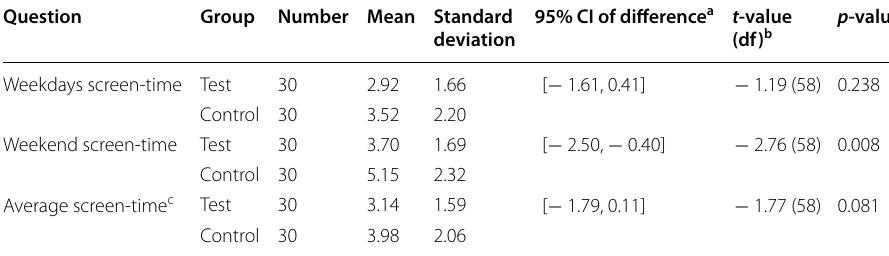
a Difference was calculated as Test–Control. CI, confidence interval b df, degrees of freedom c Calculated as the weighted